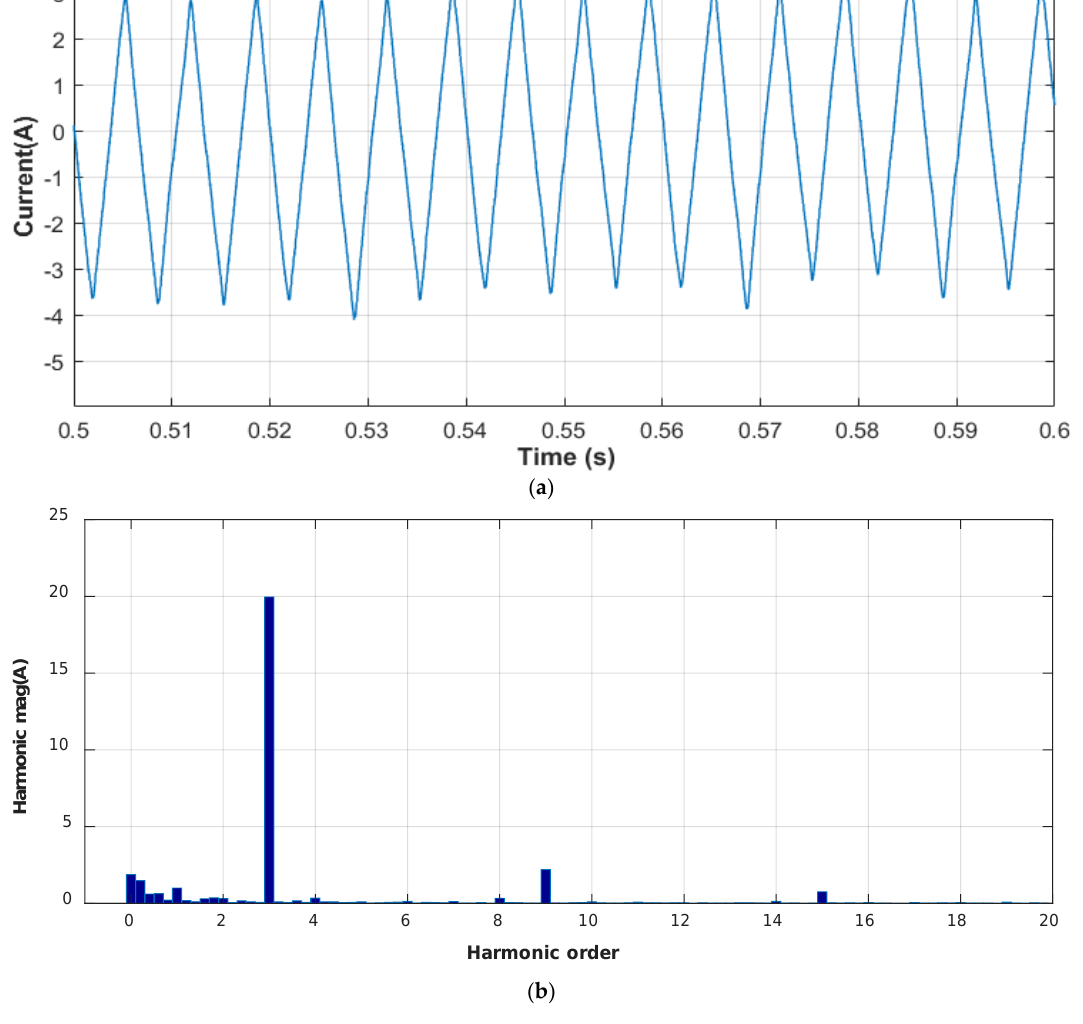
Figure 11. Simulation waveforms in parallel system with unequal inductance and without ZSCC suppression strategy: ( a ) ZSCC of system; ( b ) harmonics contained in ZSCC.